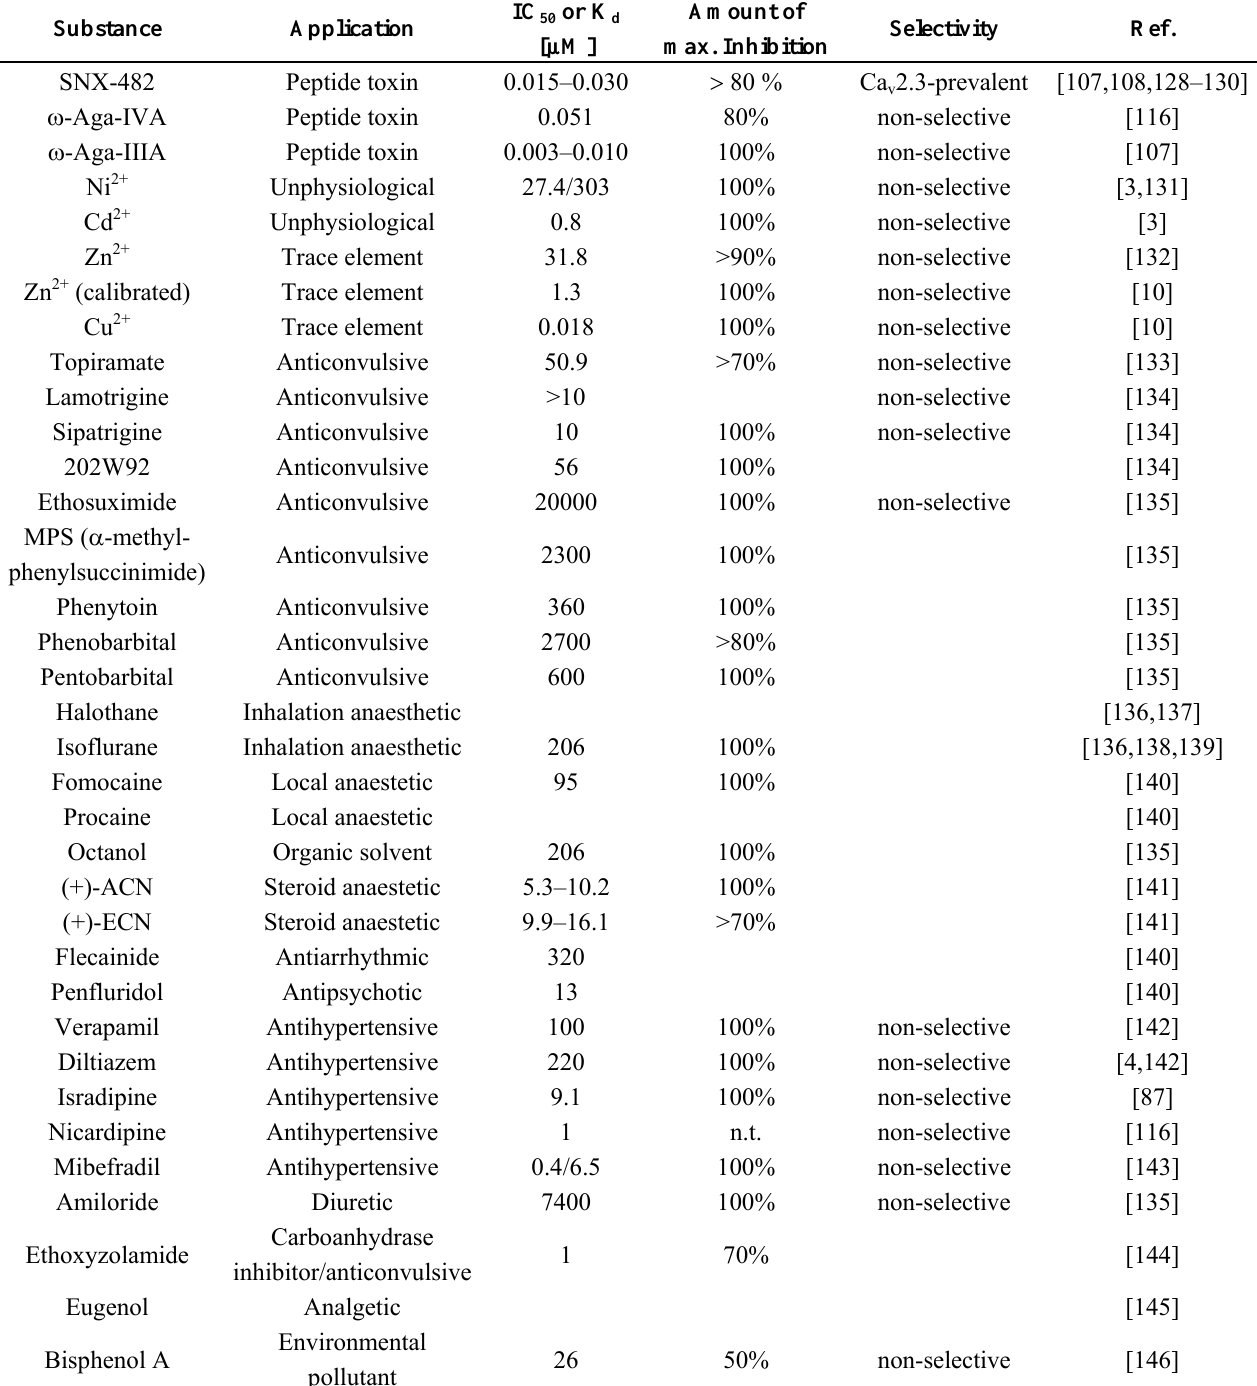
Table 3. Selected antagonists of Ca 2.3 (modified according to: Wrubel, 2009 [127]). v Recombinant Ca 2.3 was expressed in different cell lines and was cotransfected with v auxiliary subunits (  -subunits from different species). Note, trace metals must be applied under well defined conditions, which provide buffering of the cation of interest